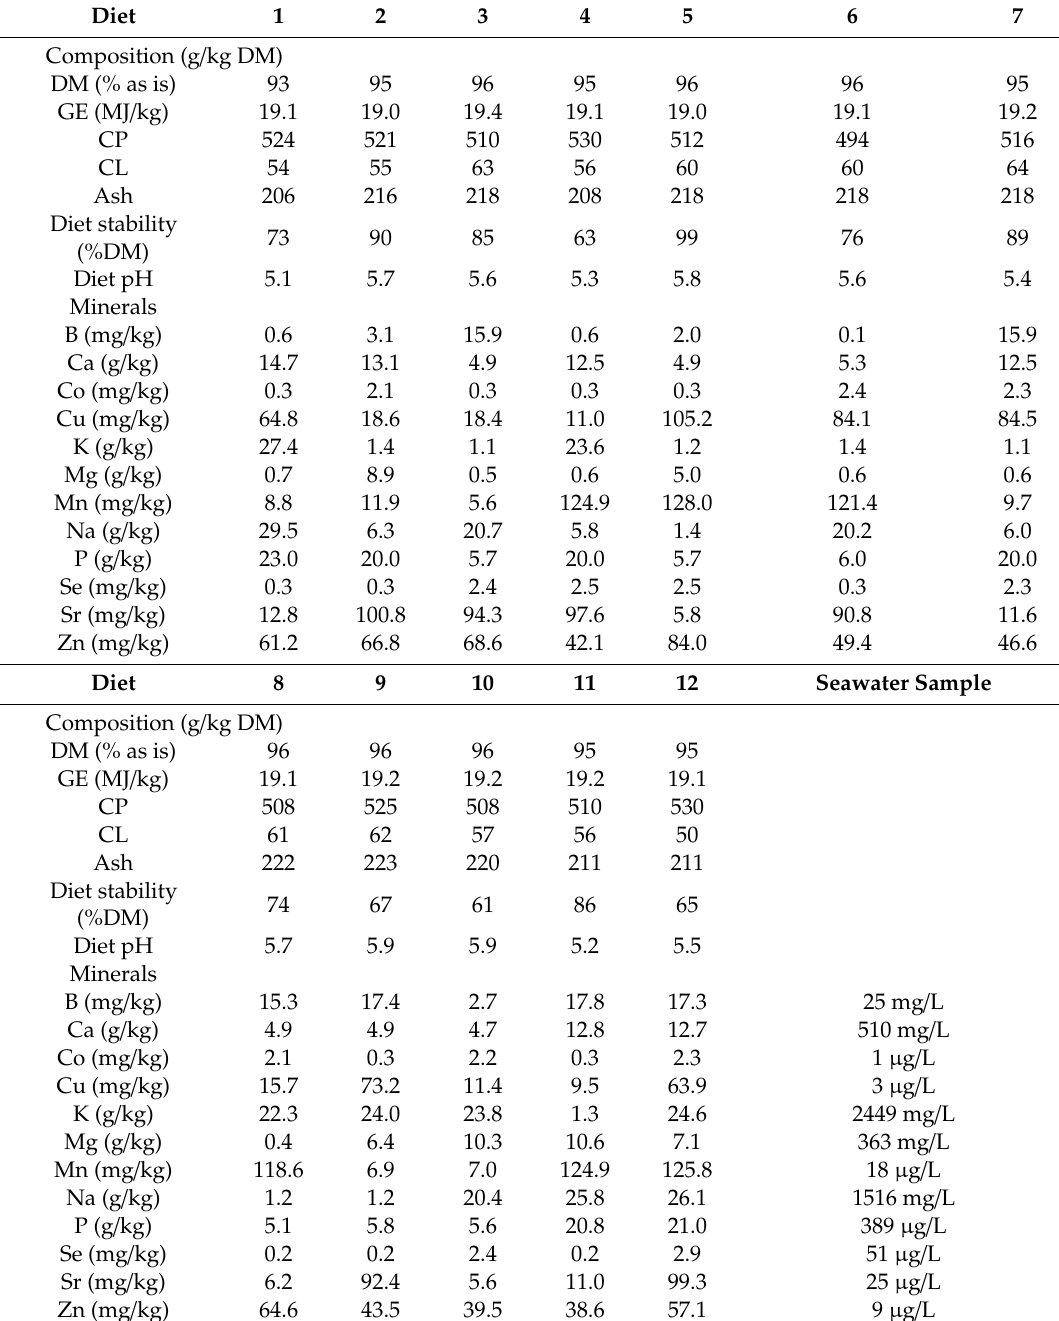
Table 3. Analyzed diet specifications and mineral concentrations of